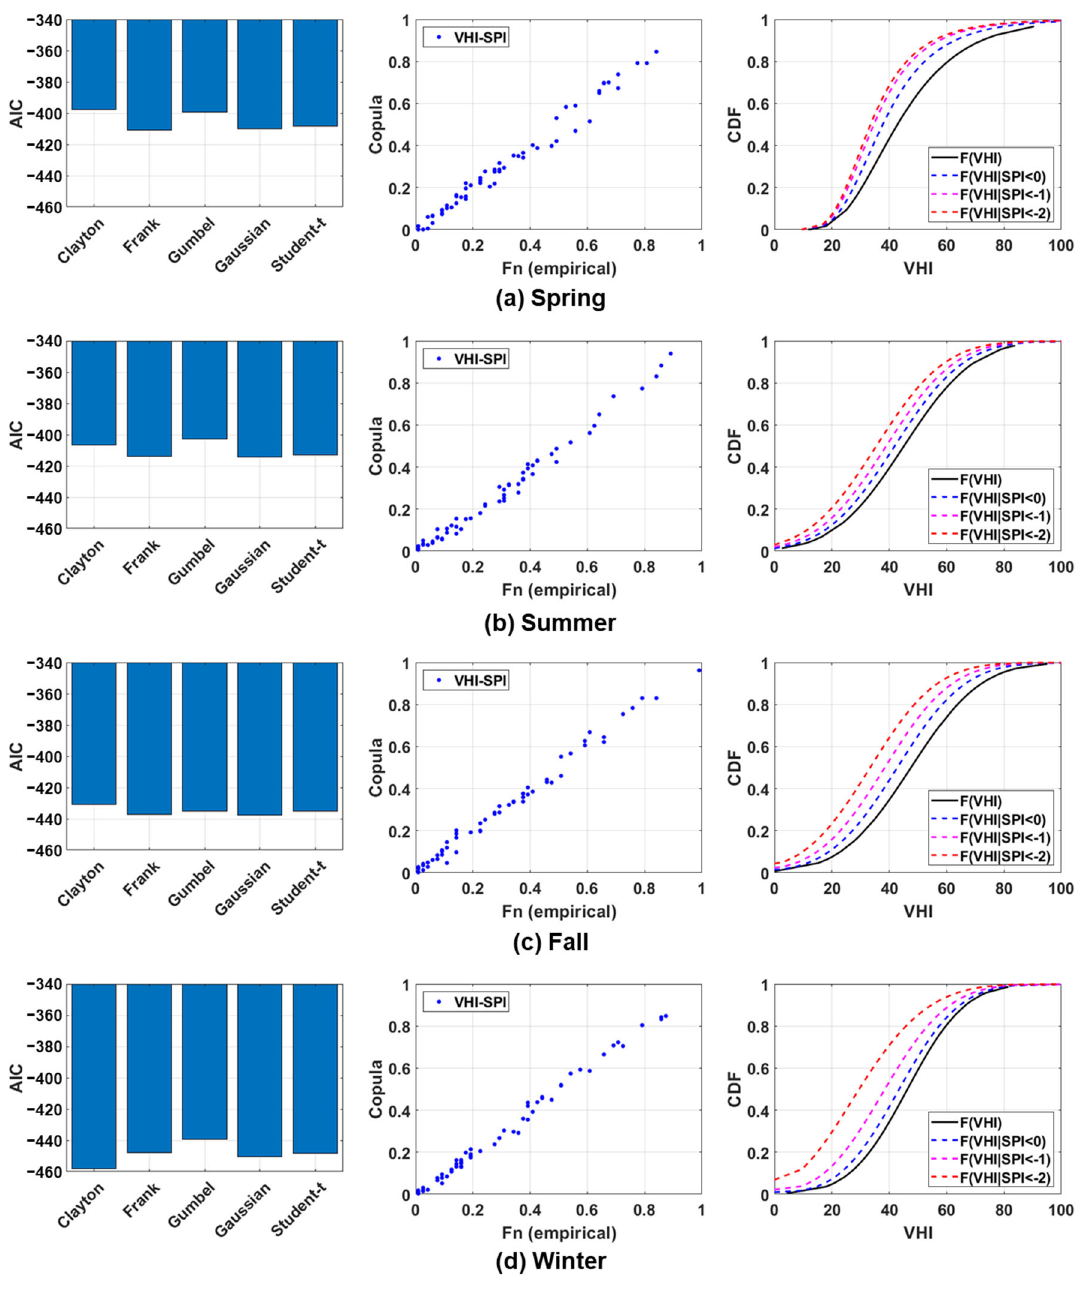
Figure 5. AIC values of five copulas for VHI and SPI ( Left ), Q ‐ Q plot using best ‐ fitted copula ( Cen ‐ ter ), and conditional CDF of VHI under SPI < 0, SPI < − 1 and SPI < − 2 ( Right ) for ( a ) spring, ( b ) summer, ( c ) fall and ( d ) winter.